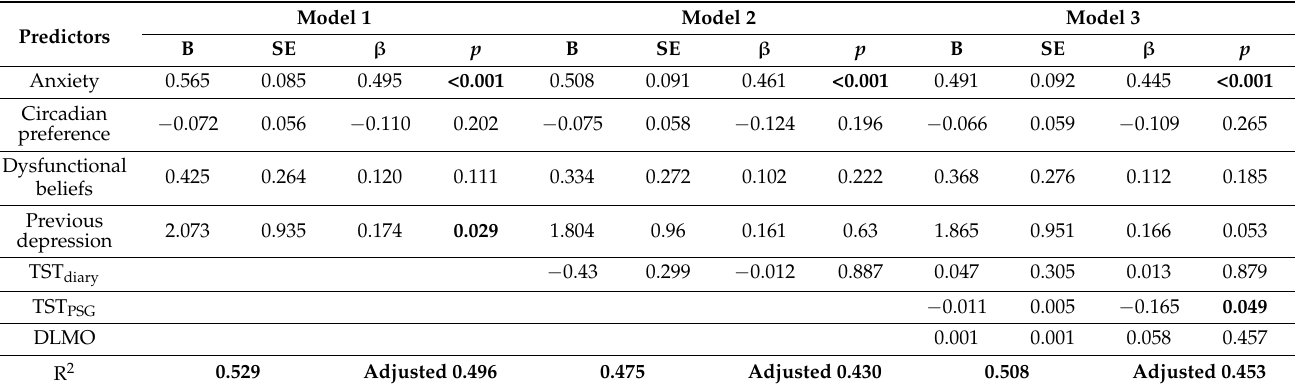
Table 3. Multiple regression analyses of associations with depressive symptoms in insomnia. Key: Circadian preference—CSM; Dysfunctional beliefs—DBAS; Anxiety—GAD-7; TST diary —total